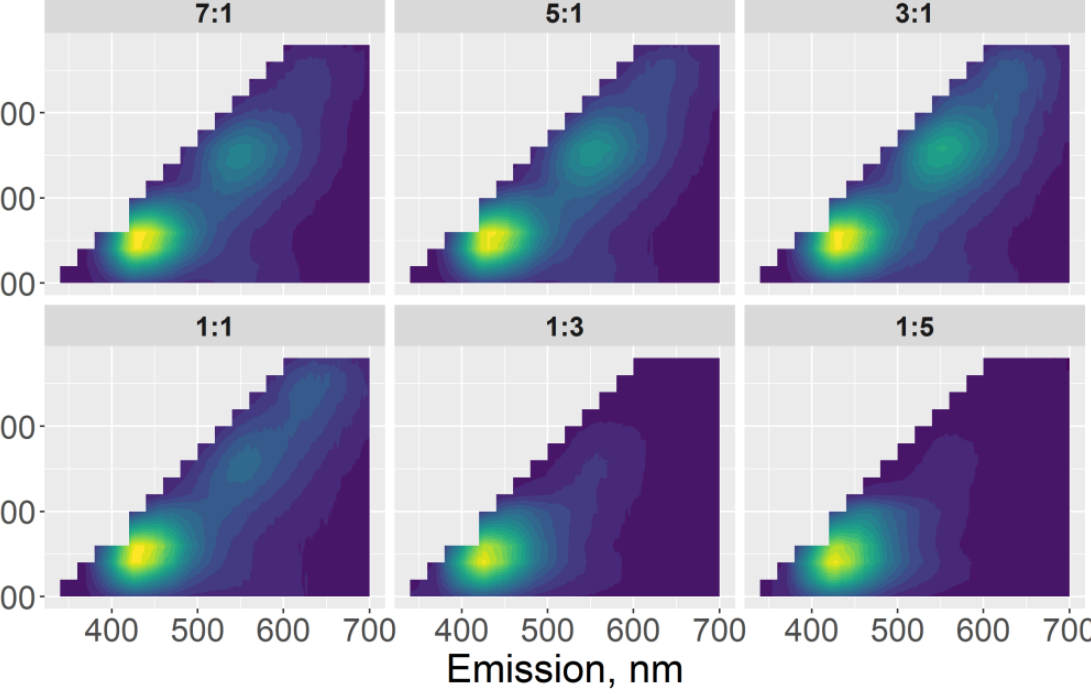
Figure 9. Maps of emission spectra of purified samples prepared from thiourea and citric acid at different excitation wavelengths. Sample composition (thiourea: citric acid) is shown in the subplot captions.